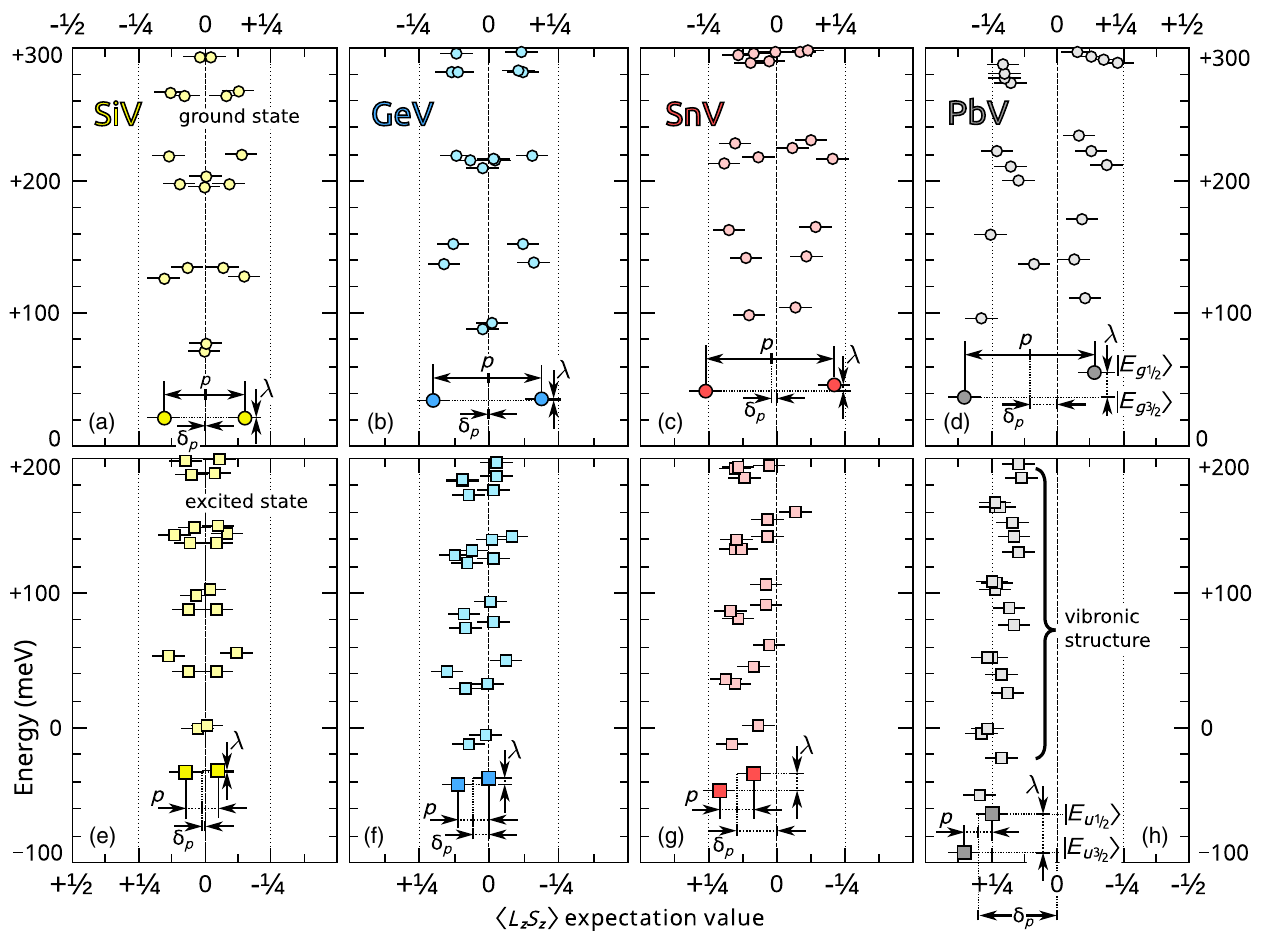
FIG. 5. Calculated eigenvalues of the adjoint DJT [Eq. (4)] and SOC [Eq. (2)] interaction for the X V ð − Þ color centers. The two lowest vibrionic ground states for g ground (a) – (d) and the optically allowed u excited eigenvalues for each figure correspond to the 2 E g;u (e) – (h) states. All the considered eigenvalues are doubly degenerate in spin dimension because of the Kramers degeneracy. Each state consists of pure ↑ or ↓ spin state; thus, the fourfold degeneracy of 2 E is fulfilled. We label the energy difference of the two lowest- g;u energy states by λ , which is directly observed in the fine structure of the ZPL in the PL spectrum known as zero-field splitting. Along the x axis we depict the eigenvalues with respect to their partially quenched spin-orbit coupling strength h L S ; thus, one can directly read z z i out the p factors from this figure. δ shows deviation of the Ham reduction factors on E and E states. The larger the δ , the less p p g;u 3 2 g;u 1 2 accurate the treatment of SOC as a perturbation over DJT. We note that a mirror symmetry at x ¼ 0 shows up for the ground state of SiV center in the entire vibronic spectrum that demonstrates that SOC can be treated as a perturbation over JTeffect. The systematic left shift at x axis for the vibronic spectrum of SnV and PbV defects implies that SOC is comparable with the JT